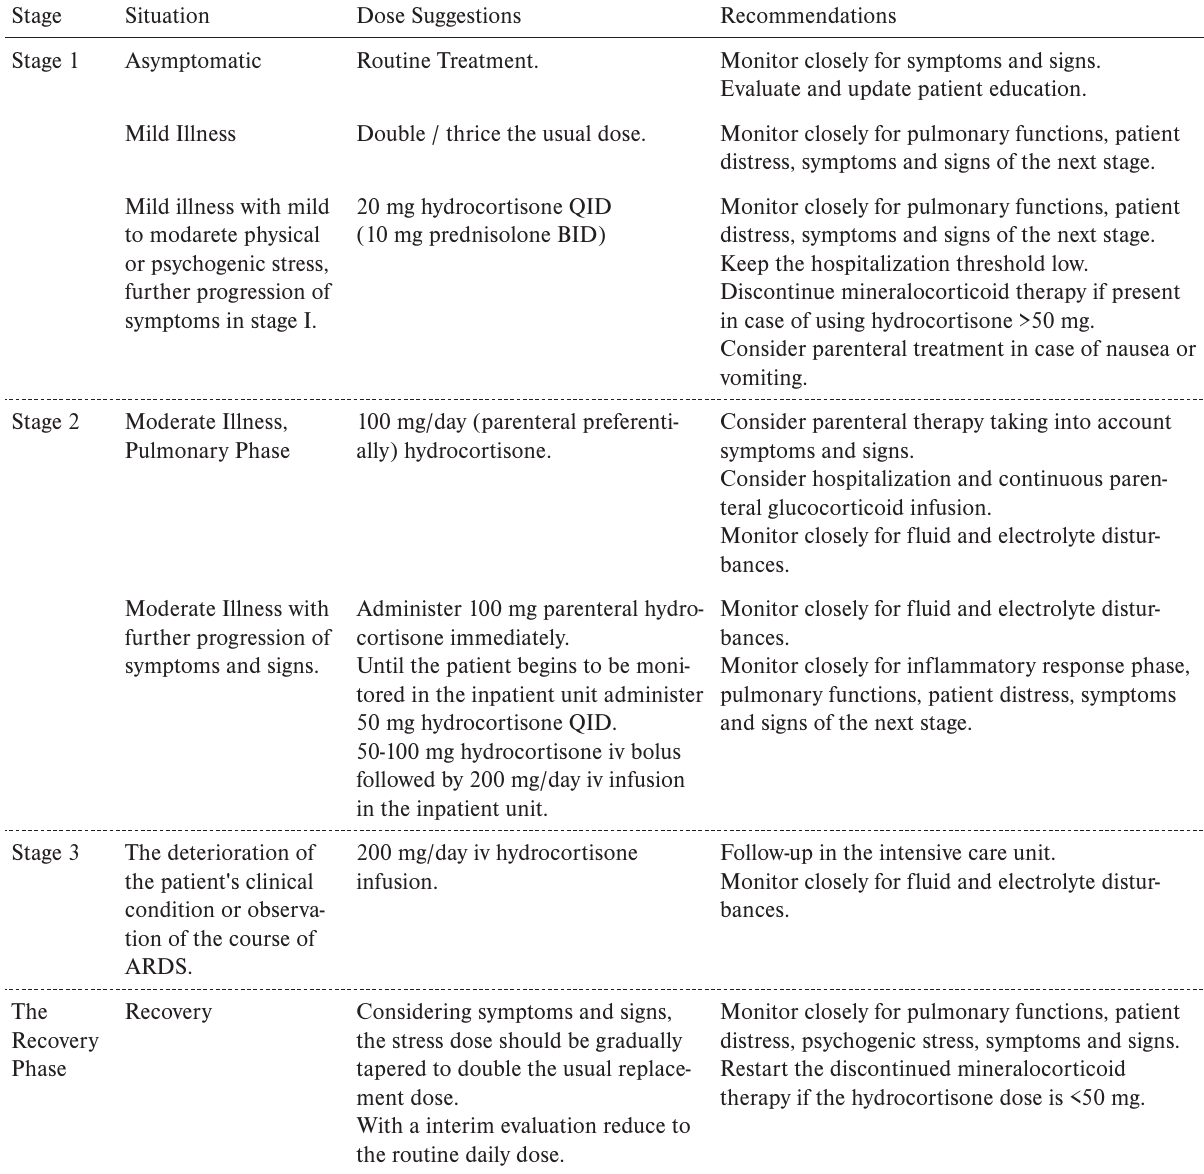
Table 1. Treatment suggestions and recommendations according to the stage of the